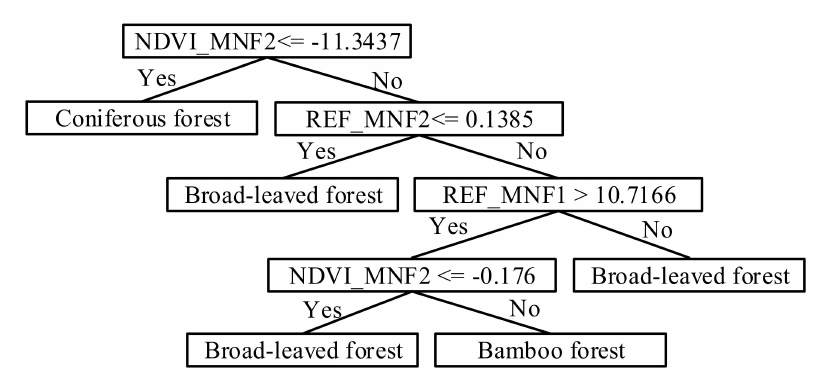
Figure 3. The optimal decision tree.